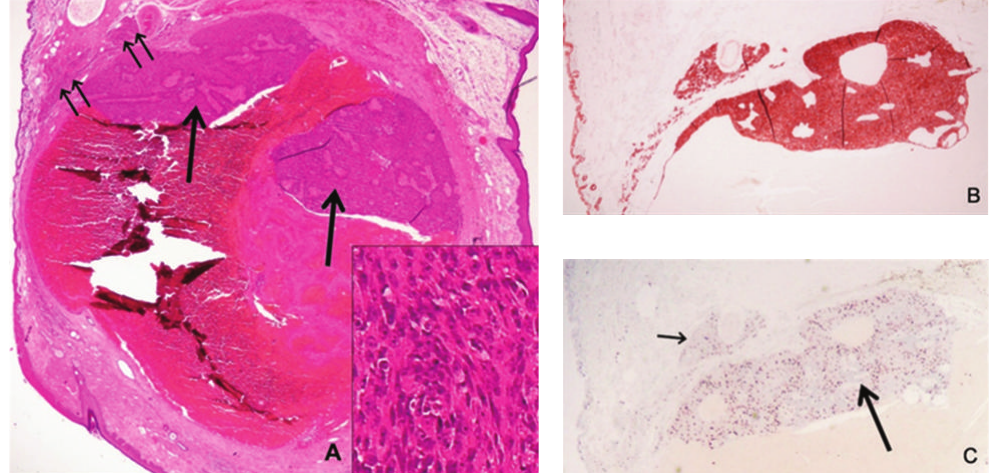
Figure 2: (A) Microscopic view showing a hemorrhagic cyst with proliferations into the lumen (single arrow) as well as in the adjacent tissue (double arrow) (H&E, 10x). The cells are pleomorphic and atypical (insert; H&E, 40x). (B) The tumor cells are strongly positive for CK18 indicating its “simple” epithelial nature (10x). (C) With anti-Ki67 a high proliferative activity is seen within the luminal part of the tumor (big arrow; 10x) as well as in the adjacent tumor nodule (small arrow;